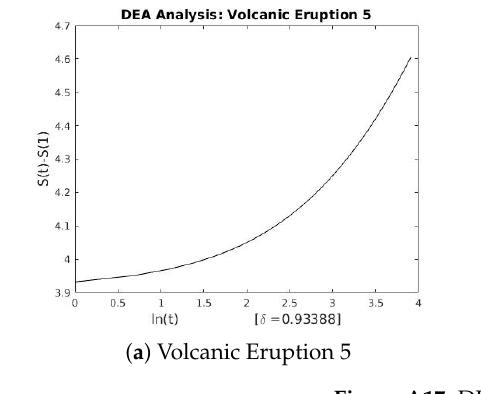
Figure A17. DEA for Volcanic Eruption 5 and 6.